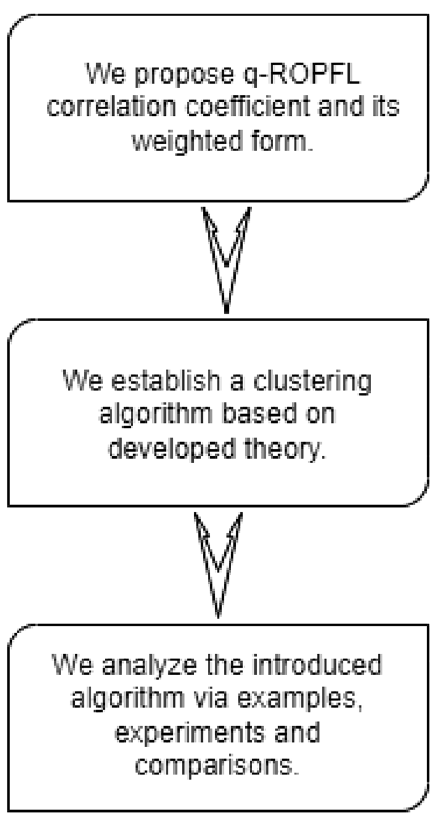
Figure 1. Graphical illustration of the proposed